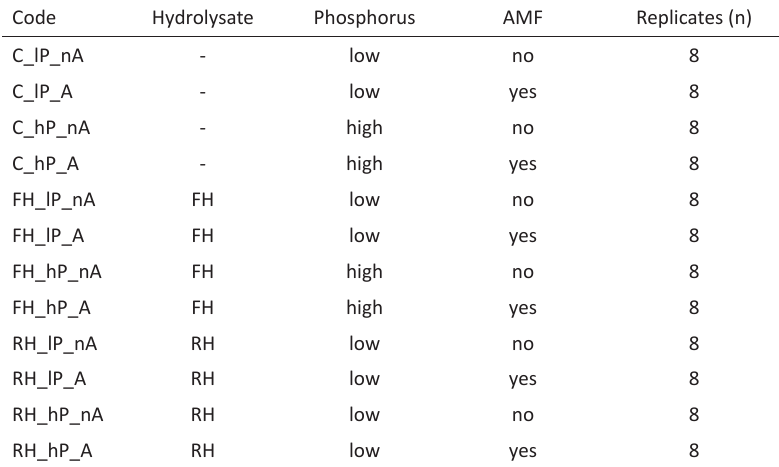
Table 2. Experimental treatments used in the pot